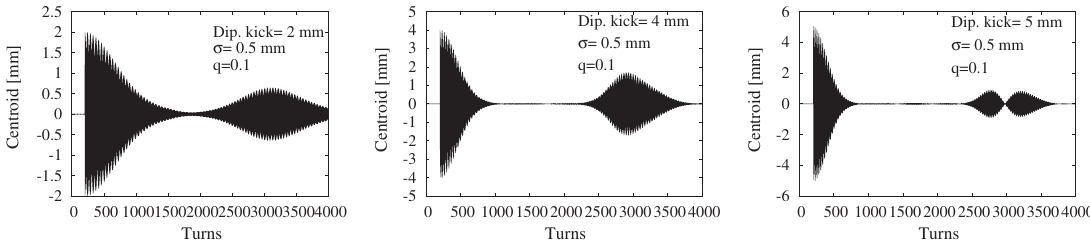
FIG. 4. Centroid evolution with different dipole kicks, constant emittance ( σ ¼ 0 . 5 mm), and constant quadrupole kick q ¼ 0 . 1 . The dipole kicks increase from left to right. The decoherence time decreases with increasing dipole kick.